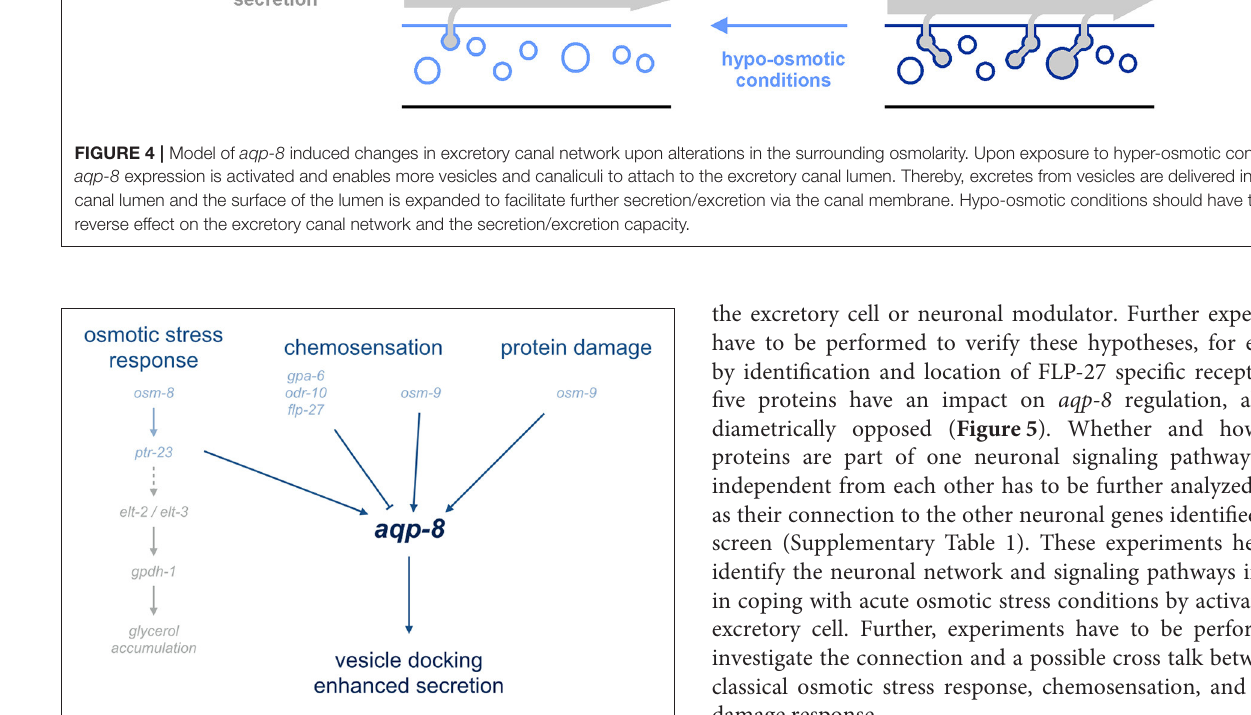
FIGURE 5 | Overview of pathways involved in aqp-8 regulation. The overview illustrates the signaling pathways involved in aqp-8 regulation. Genes connected to or involved in the diverse pathways are depict in light blue. Represented in light gray are the identified components of osmotic stress response pathway leading to glycerol accumulation. A dashed line indicates the unknown components of the gpdh-1 activation